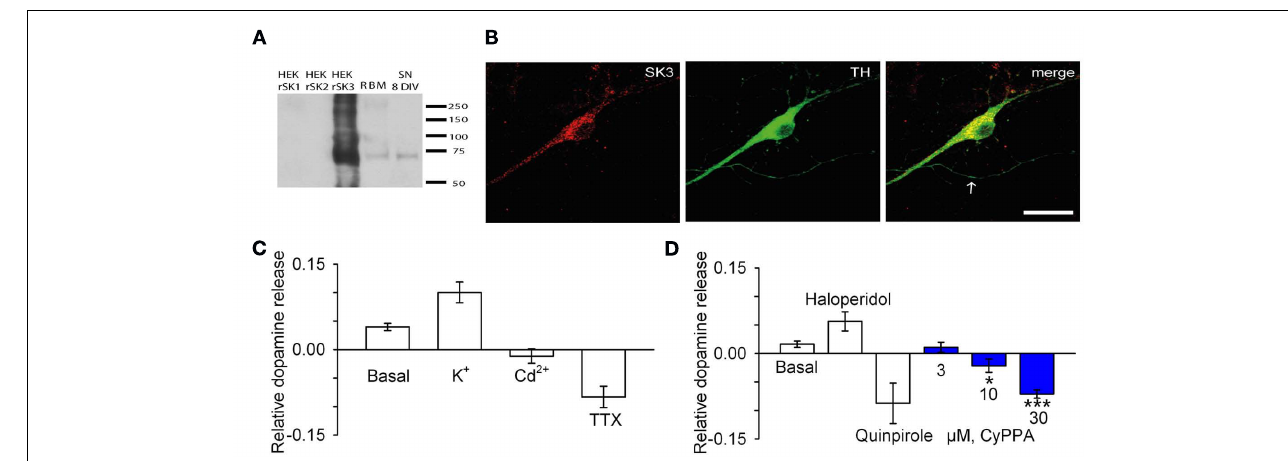
FIGURE 5 | CyPPA inhibits spontaneous and evoked release of dopamine formTH/SK3 positive cultured rat midbrain neurons. (A) Western blot detection of SK3 in rat midbrain cultures. Extracts of HEK293 cells transiently transfected with rSK1, rSK2, and rSK3 and adult rat brain membranes (RBM) as well as lysates from cultured midbrain neurons were separated on 4–15% SDS-PAGE and immunoblotted with anti-SK3 antibody. A band of approximately 70kDa was detected in midbrain cultures, RBM lysates, and HEK293 cells transfected with rSK3.This band was absent in lanes loaded with HEK293 cells expressing rSK1 and rSK2. (B) Immunodetection of SK3 subunits in rat midbrain cultures.